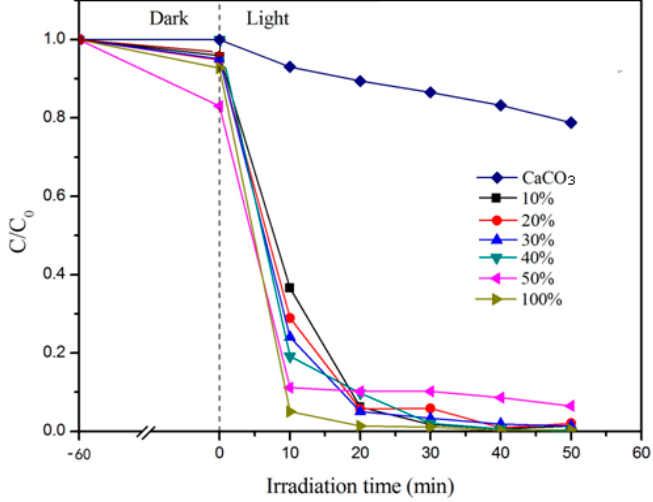
Figure 2. Effect of mass ratio of TiO 2 on the properties of the composite photocatalyst. Figure 2. E ff ect of mass ratio of TiO 2 on the properties of the composite